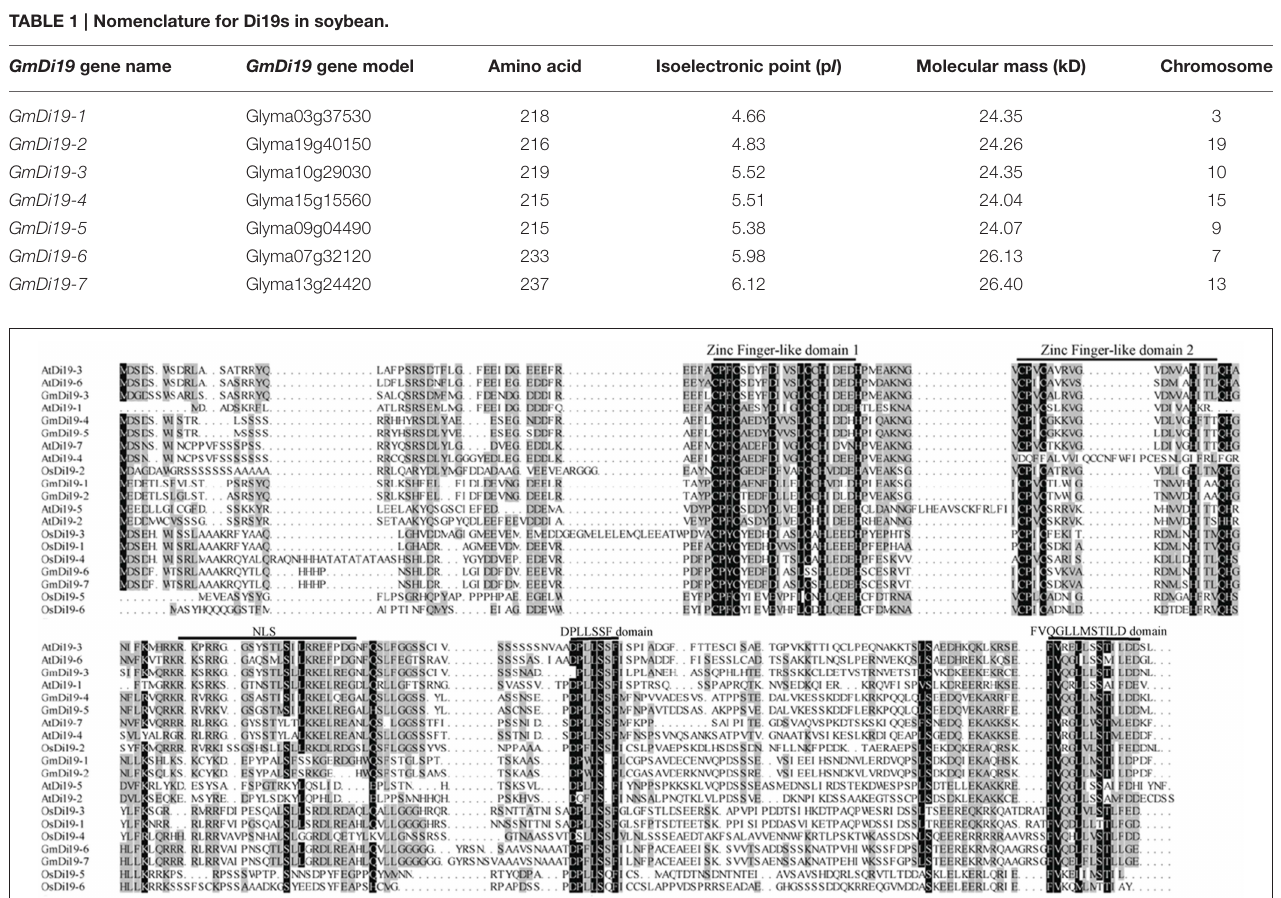
FIGURE 1 | Multiple alignments of soybean Di19s, AtDi19s, and OsDi19s.